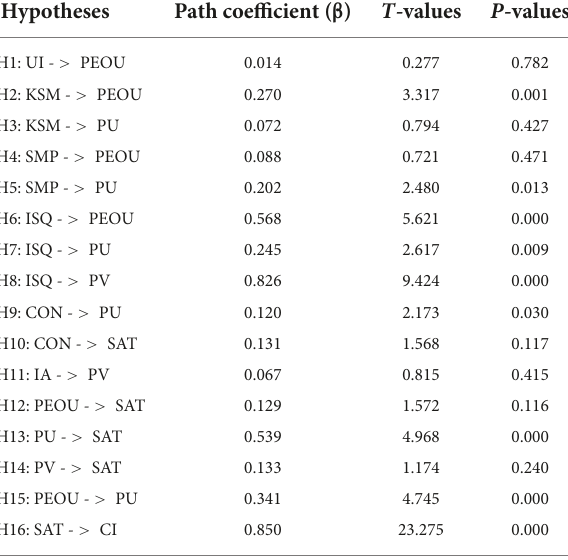
TABLE 3 Empirical